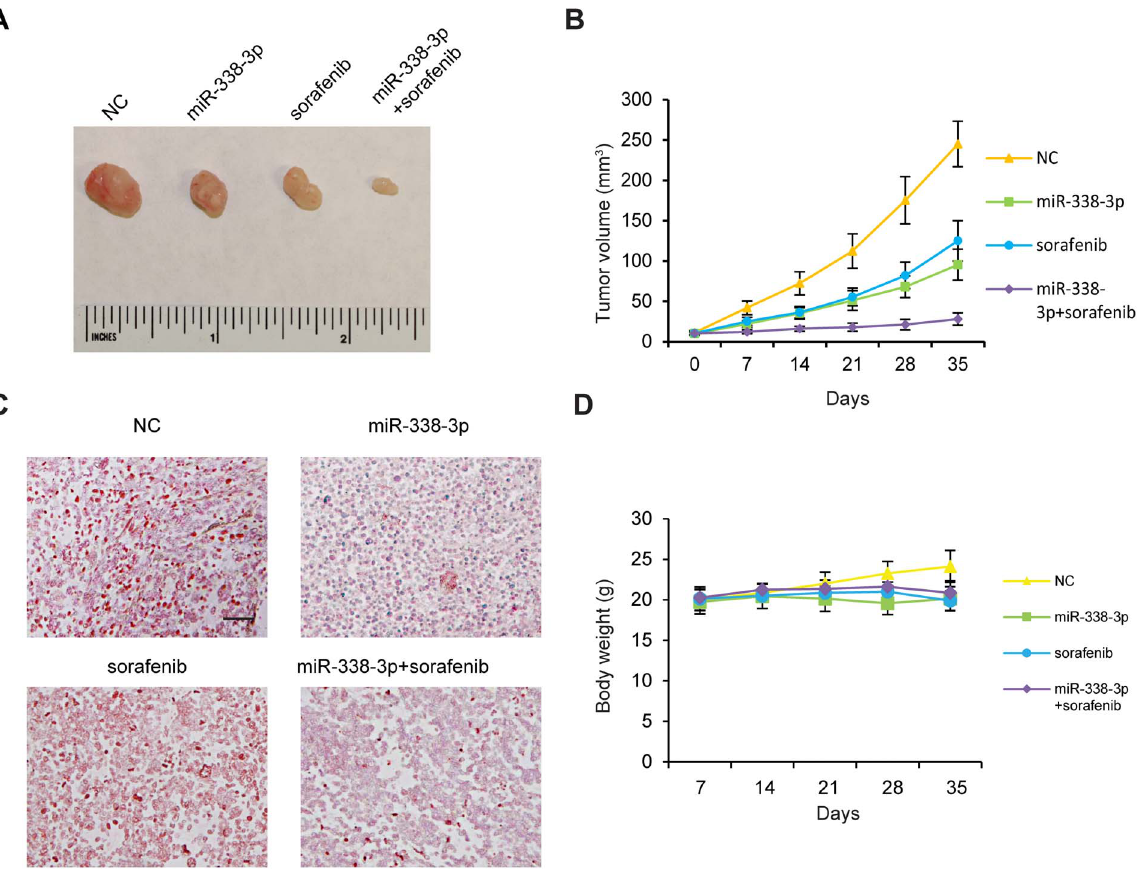
Fig. 7. miR-338-3p and sorafenib synergistically inhibited subcutaneous tumor growth. (A) Representative photos of tumor tissues from different treatment groups 35 days post-injection. (B) Mean tumor volumes measured every seven days. (C) Representative photos of sections stained with an anti- HIF-1 a antibody; scale bar 0.15 mm. (D) Average mouse body weight. n 5 8 in each group. Data are shown as mean ¡